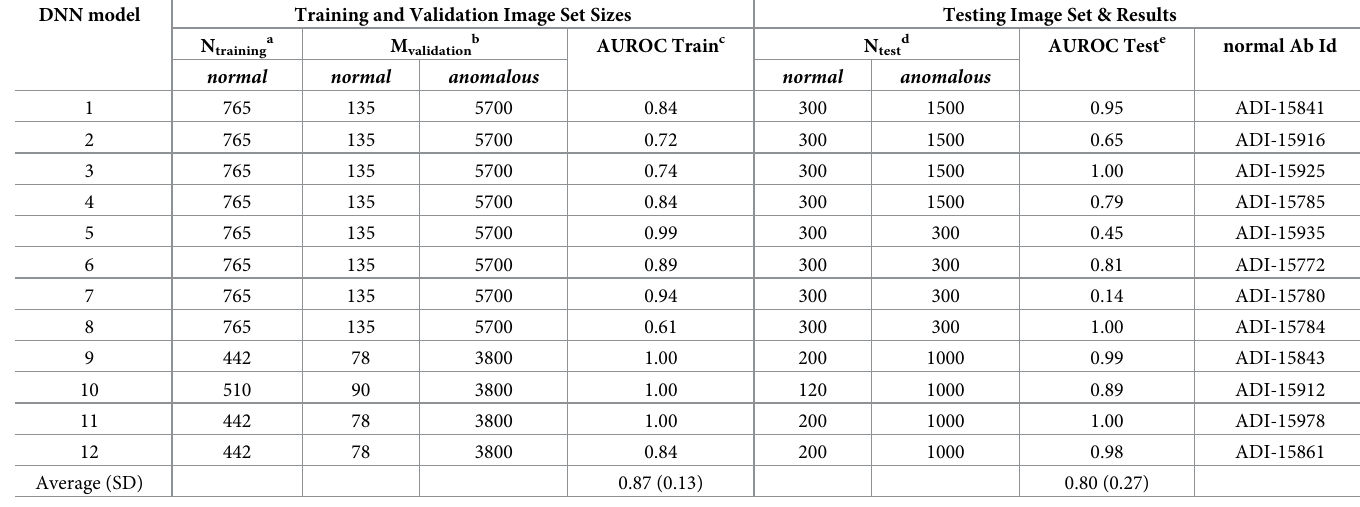
Table 10. Statistical summary of 12 DNN models trained to distinguish Abs from a specific family lineage using the Robust Convolutional Autoencoder one-class classification method. DNN model Training and Validation Image Set